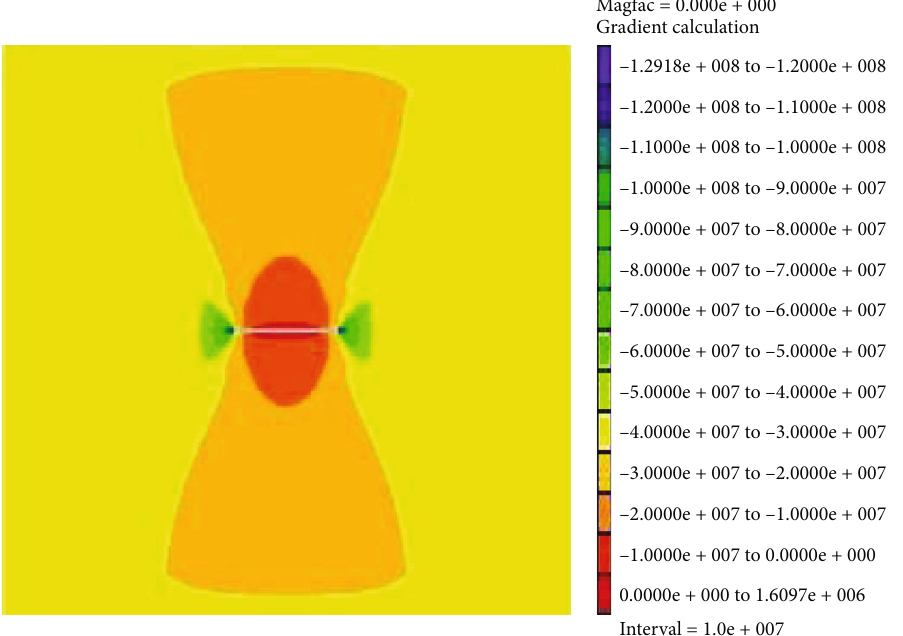
Figure 9: Contour map of stress after slotting